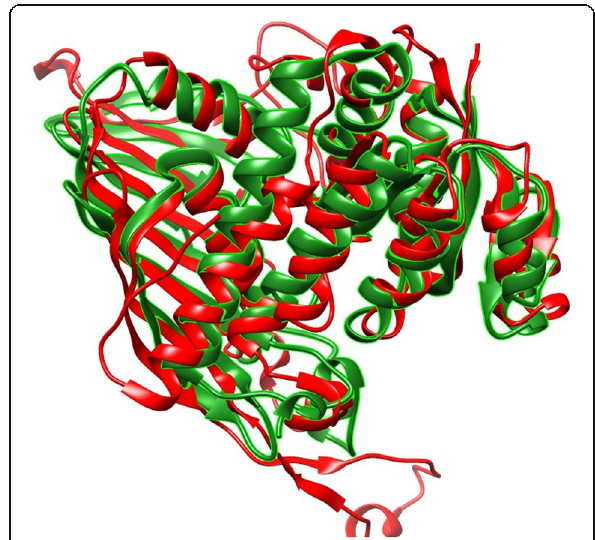
Fig. 5 Structure superimposition of the inositol dehydrogenase. The figure represents superimposed structures of inositol 2-dehydrogenase using the HOMSTRAD database and visualized using UCSC chimera. The orthologues have RMSD on Ca atoms = 2.837 Å units